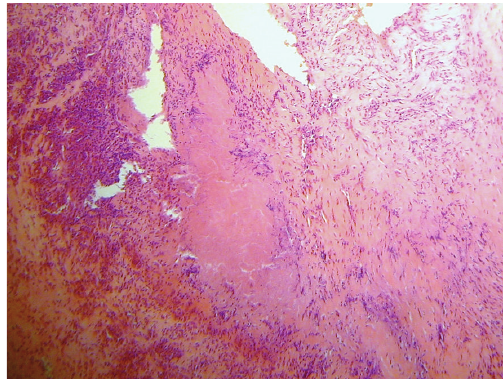
Figure 2: High powered microscopy of rheumatoid granulomata found in aortic